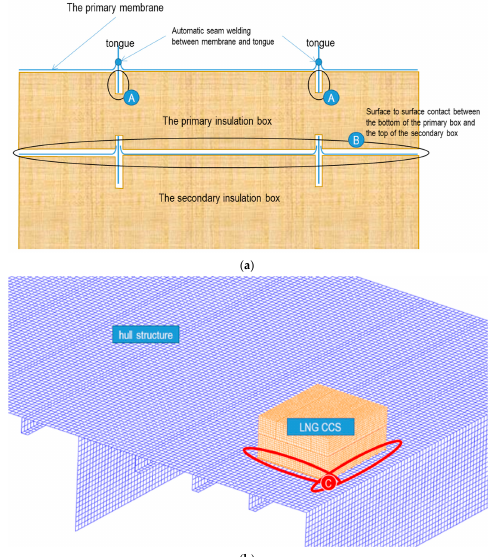
Figure 3. Schematic of the structural boundary nonlinearity in LNG CCS application. ( a ) Sectional view of the LNG cargo containment system; ( b ) Onboard condition.